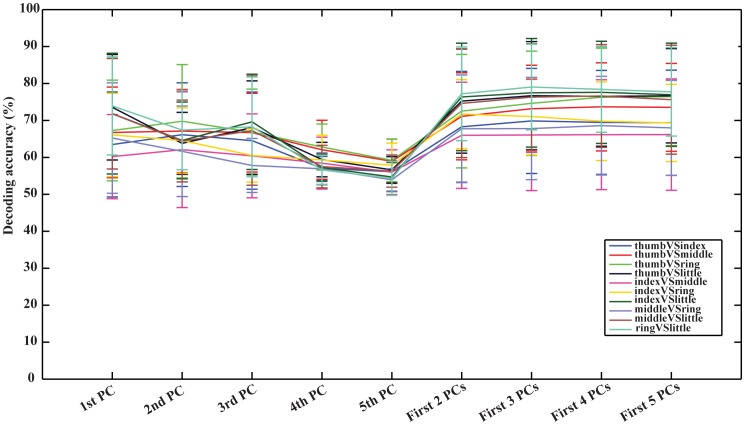
Decoding accuracies using single and multiple principal component(s) in all subjects.Classifications were done using 50 EEG channels (figure 1(c)).